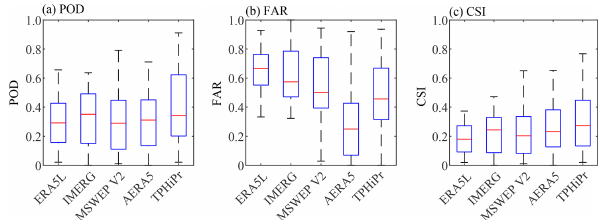
Figure 14. Comparison of (a) R90p, (b) R90p_INT and (c) R90p_FRQ for rain gauge data (OBS), ERA5L, IMERG, MSWEP v2, AERA5 and TPHiPr. R90p represents the 90th percentile of daily precipitation on wet days for each dataset. R90p_INT repre- sents the average precipitation intensity of daily precipitation larger than R90p. R90p_FRQ represents the frequency of daily precipita- tion larger than